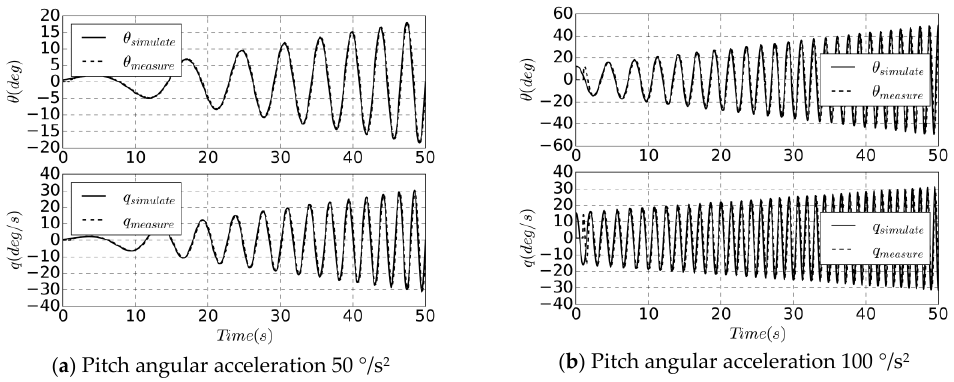
Figure 17. Test results under different angular accelerations.